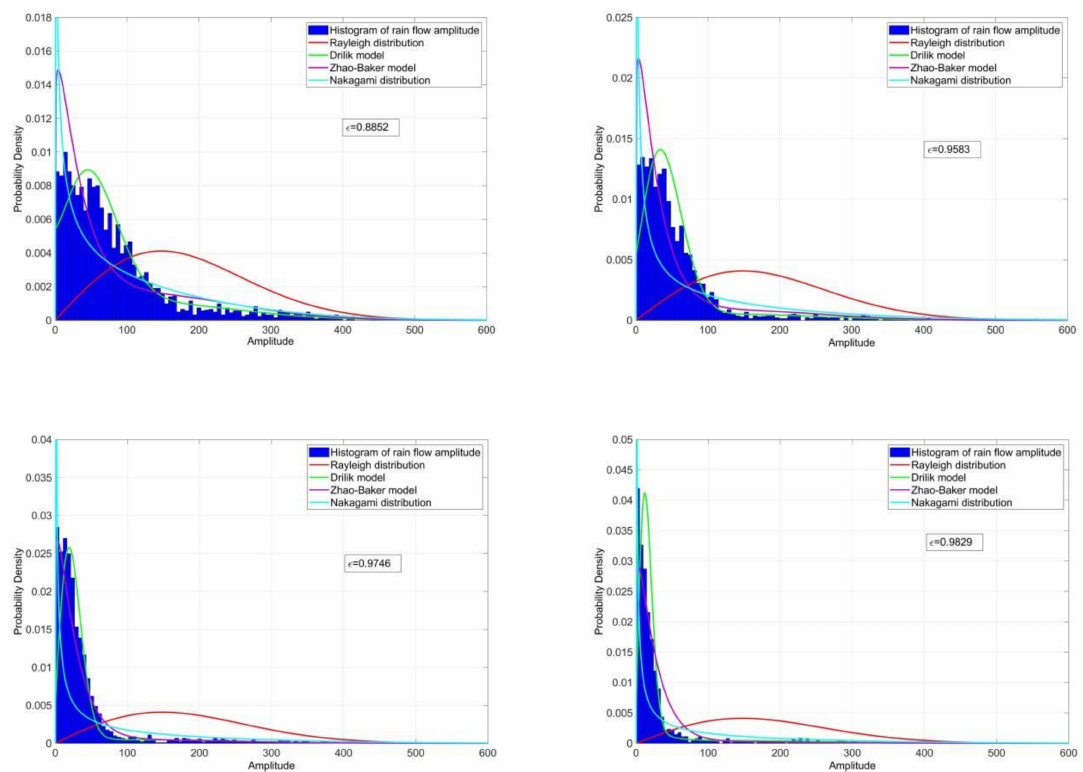
Figure A3. Probability density distribution of the amplitude of rain flow (bimodal spectrum).